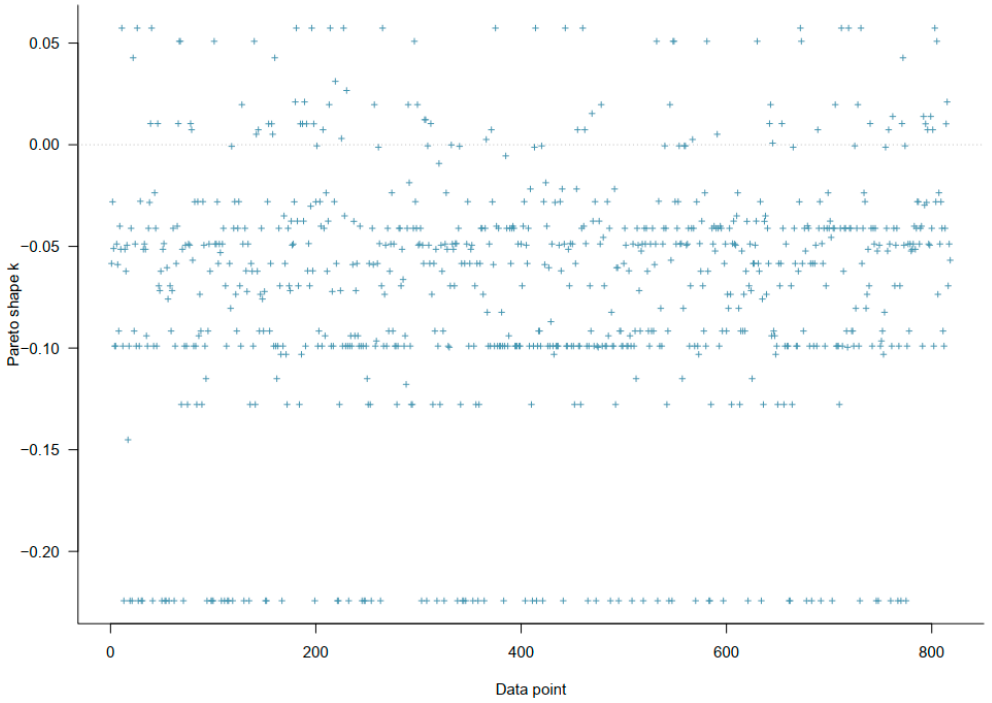
Figure 1. Model 1 ′ s PSIS diagnostic plot. Figure 1. Model 1’s PSIS diagnostic